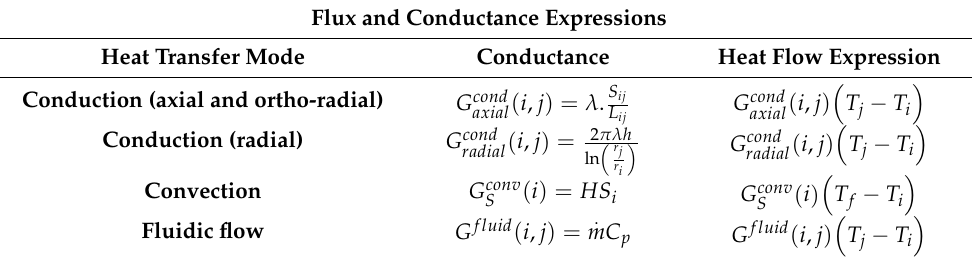
Table 11. Flux and conductance expressions for each transfer mode. Flux and Conductance Expressions Heat Transfer Mode